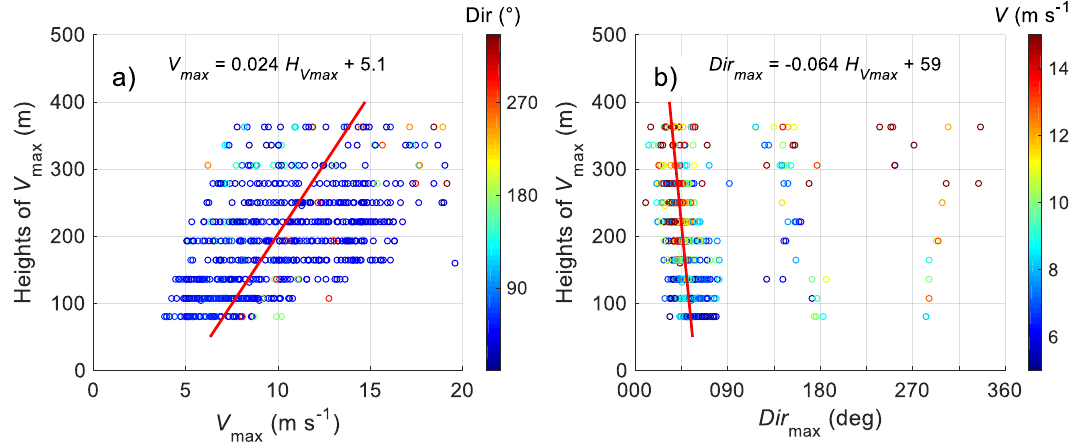
Figure 27. Wind speed ( a ) and wind direction ( b ) in the LLJ core versus core height. Red lines indicate linear fitting functions.